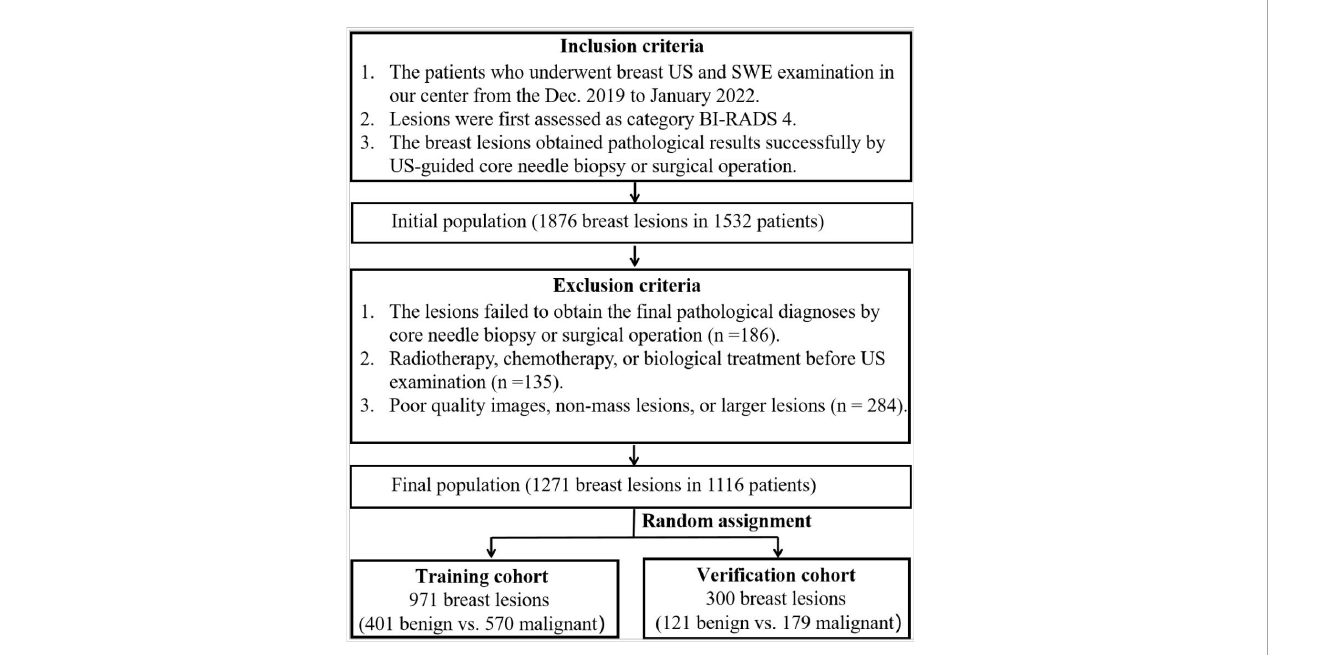
FIGURE 1 Flowchart of breast lesions recruitment.